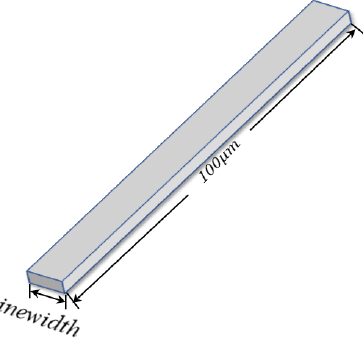
Figure 3. Model of the gold line to be measured.